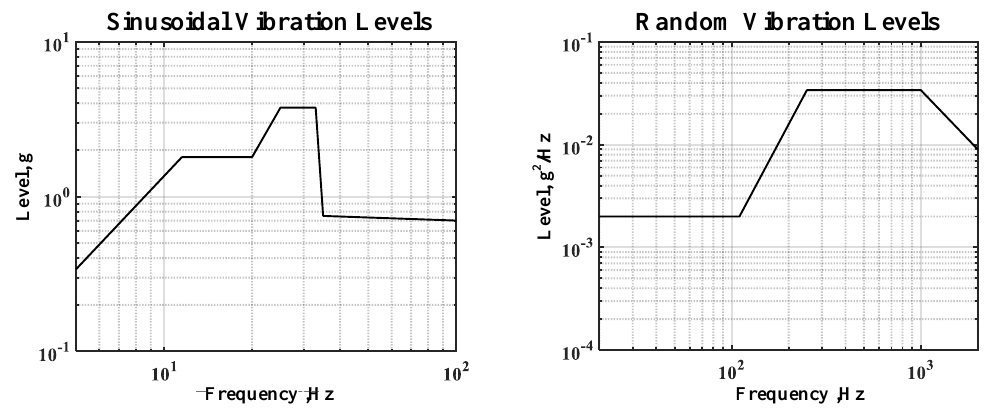
Figure 8. Sinusoidal ( left ) and random vibration ( right ) levels inflicted on the propellant tank as part of the propellant tank qualification procedure.